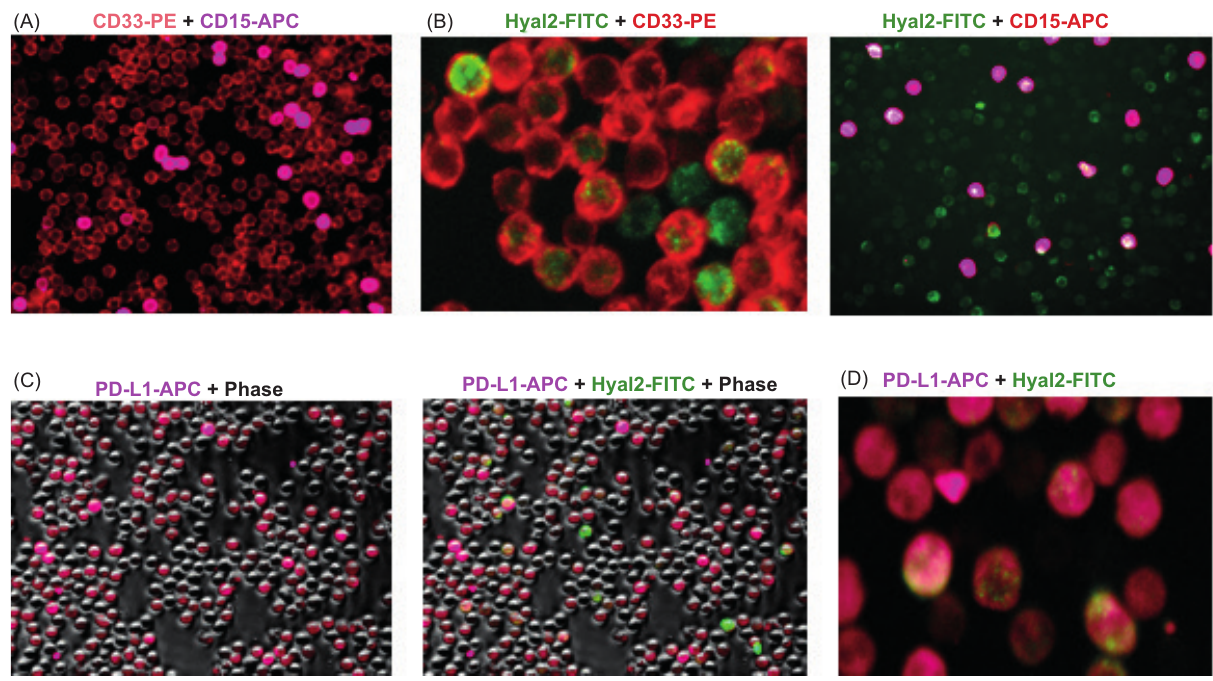
Figure 1: The increased presence of PD-L1 and Hyal2-expressing myeloid cell subsets in the patient’s peripheral blood. CD11b myeloid cells were isolated from the peripheral blood using magnetic beads. Freshly isolated cells were stained with CD33-PE, CD15-PE, and Hyal2-FITC antibodies (images A, B), or with PD-L1-APC and Hyal2-FITC antibodies (images C, D). Repre- sentative IF images are